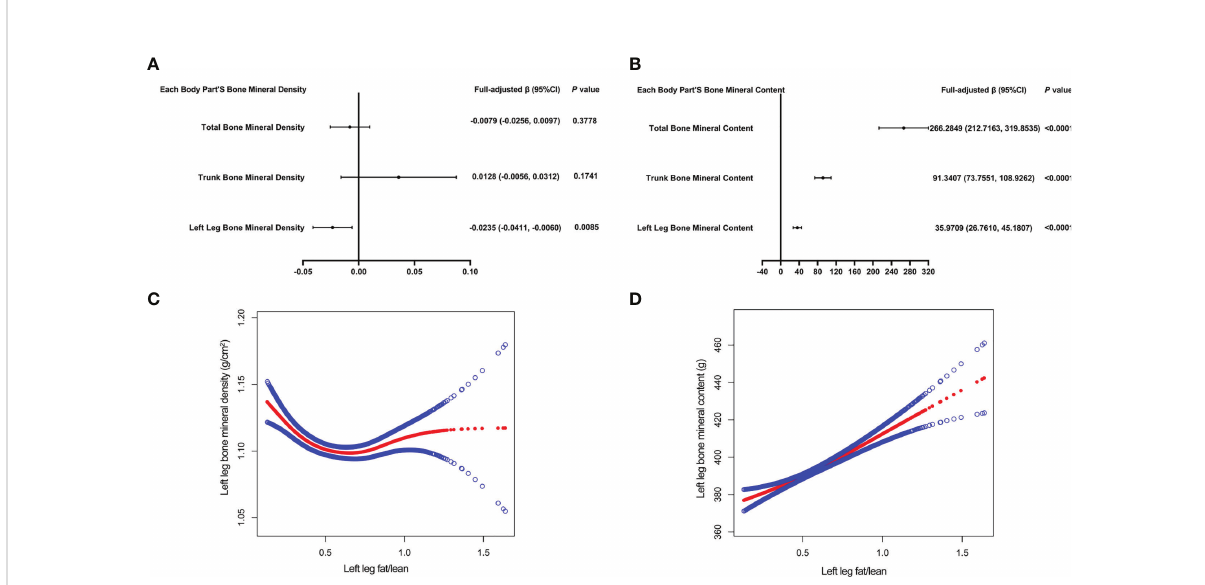
FIGURE 4 The forest plots of each body part ’ s bone mineral density or bone mineral content and left leg fat/lean mass, respectively (A, B) . Association of left leg bone mineral density and bone mineral content with left leg fat/lean mass (C, D) . The solid red line represents the smooth curve fi t between variables. Blue bands represent the 95% con fi dence interval from the fi t (C, D) . All confounding factors were